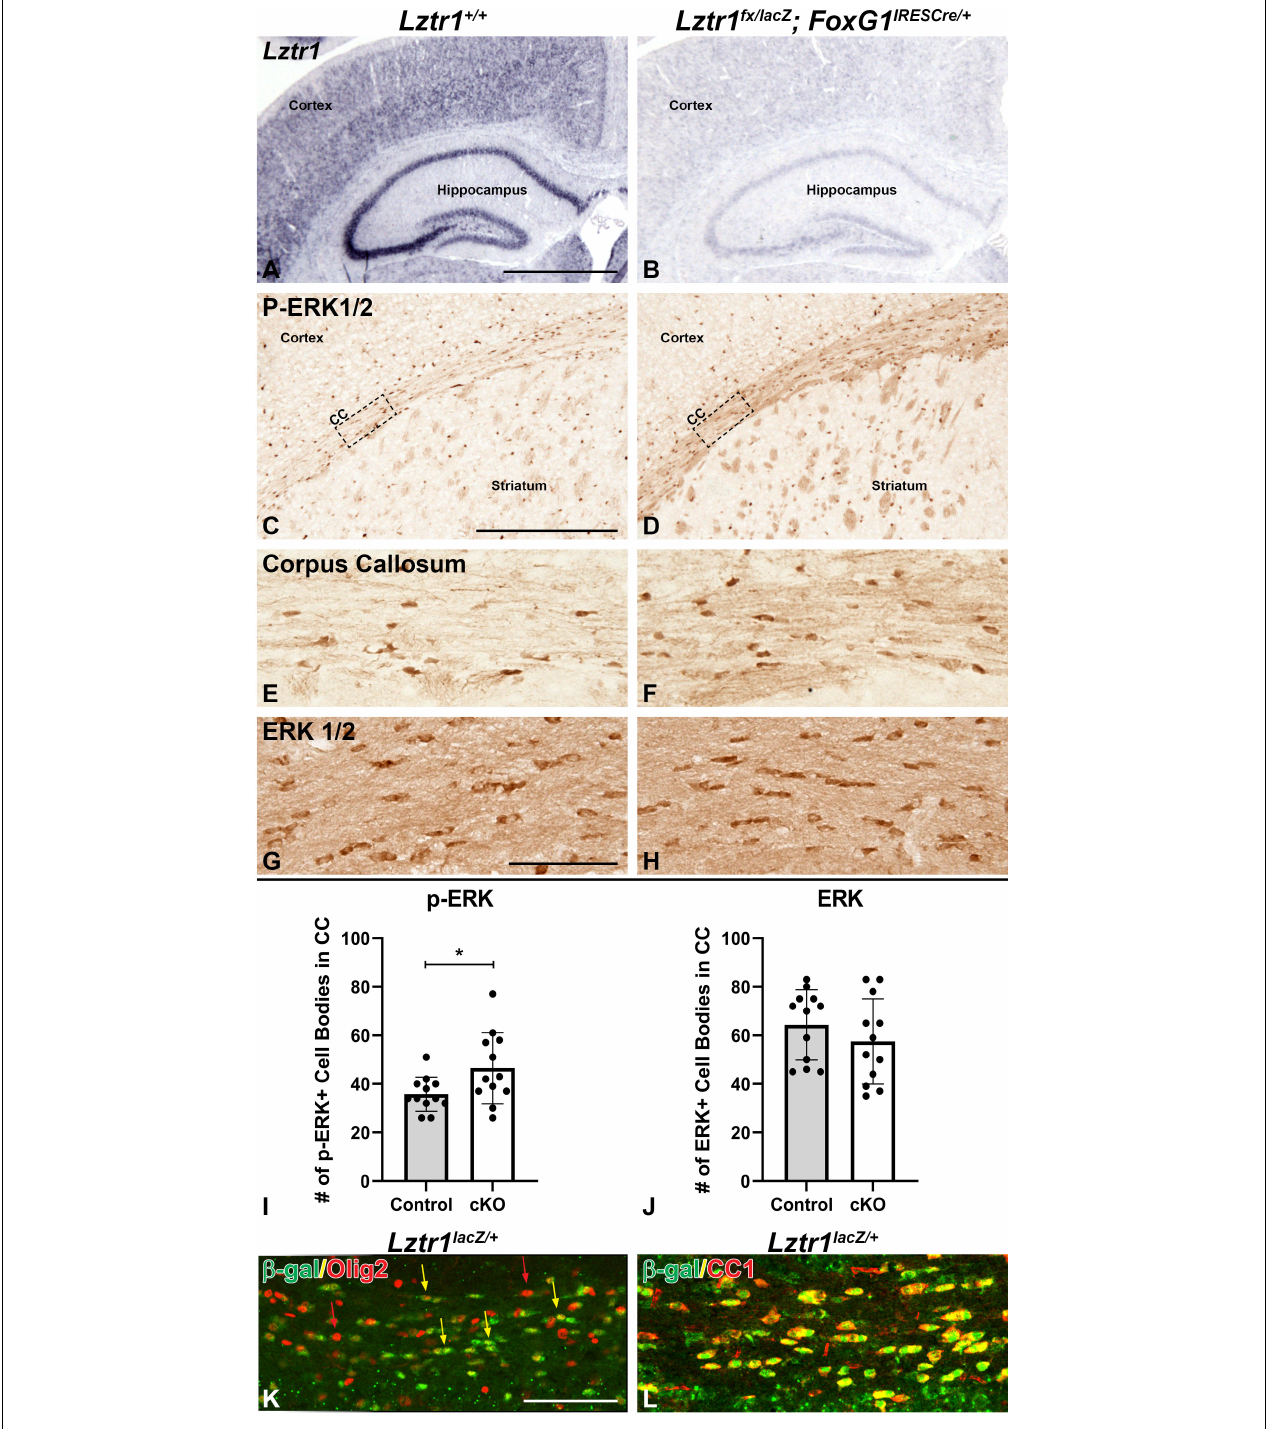
FIGURE 2 | Conditional deletion of Lztr1 using FoxG1 IRES - Cre / + results in increased p-ERK1/2 expression in postnatal animals at postnatal day 21. Lztr1 gene expression shows a reduction of expression in the cKO, especially in the cortex and hippocampus (A,B) . Lztr1 cKO shows increased p-ERK1/2 expression (D,F) compared to controls (C,E) . Increased p-ERK1/2 expression is especially observable in major white matter tracts of the corpus callosum (C–F) . Total ERK1/2 staining is similar in Lztr1 cKO compared to control in the corpus callosum (G,H) . Quantification of p-ERK1/2 and ERK1/2 by number of cell bodies per field in the CC (I,J) . β -gal reporter expression in Lztr1 lacZ / + mice shows co-expression with oligodendrocyte lineage marker Olig2 (K) and mature oligodendrocyte marker CC1 (L) . Scale bars = 1 mm for (A,B) , 500 µ m for (C,D) , and 100 µ m for (E–H,K,L) . BLA, basolateral amygdala; CC, corpus callosum. The asterisk in (I) refers to a p < 0.05 as detected by Student’s t